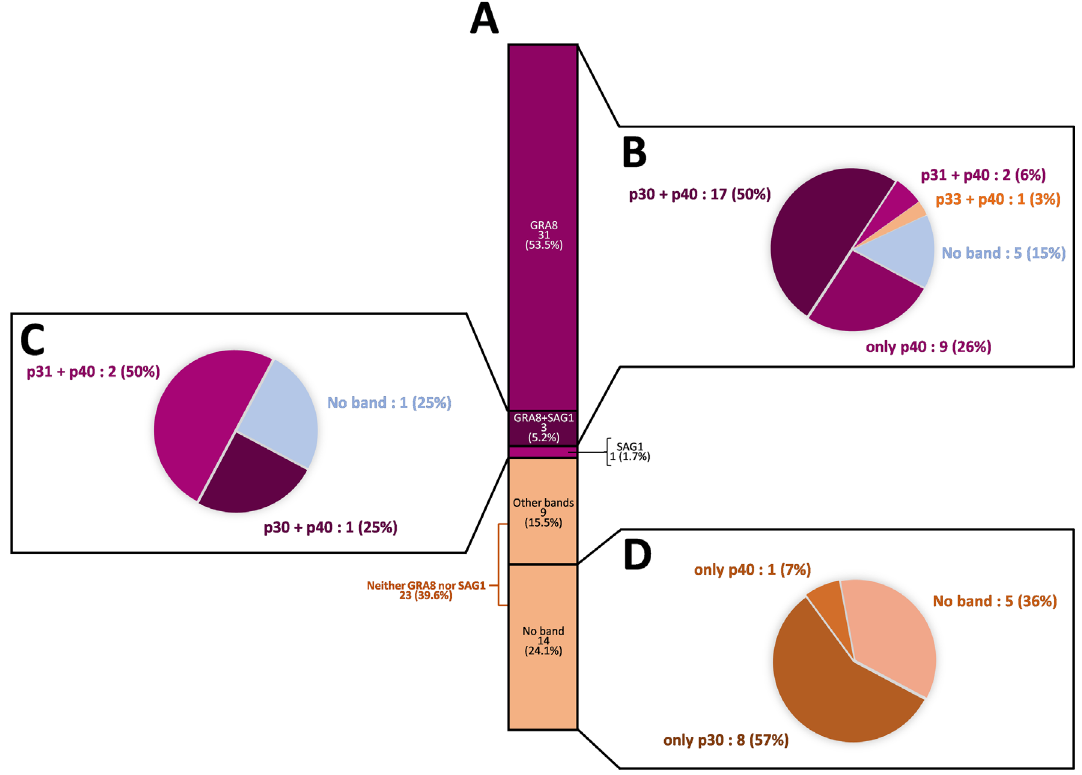
Figure 3. Description of the immunoblot pro fi les of the 58 negative LDBio (cid:1) tests (true false-positives with Architect (cid:1) ). (A) Proportion of recom Line (cid:1) pro fi les positive for GRA8, SAG1, GRA8+SAG1, other bands or no band, among the 58 negative LDBio (cid:1) tests. (B) LDBio (cid:1) pro fi les of the GRA8-positive recom Line (cid:1) pro fi les. (C) LDBio (cid:1) pro fi les of the SAG1-positive recom Line (cid:1) pro fi les. (D) LDBio (cid:1) pro fi les of the “ no band ” recom Line (cid:1) pro fi